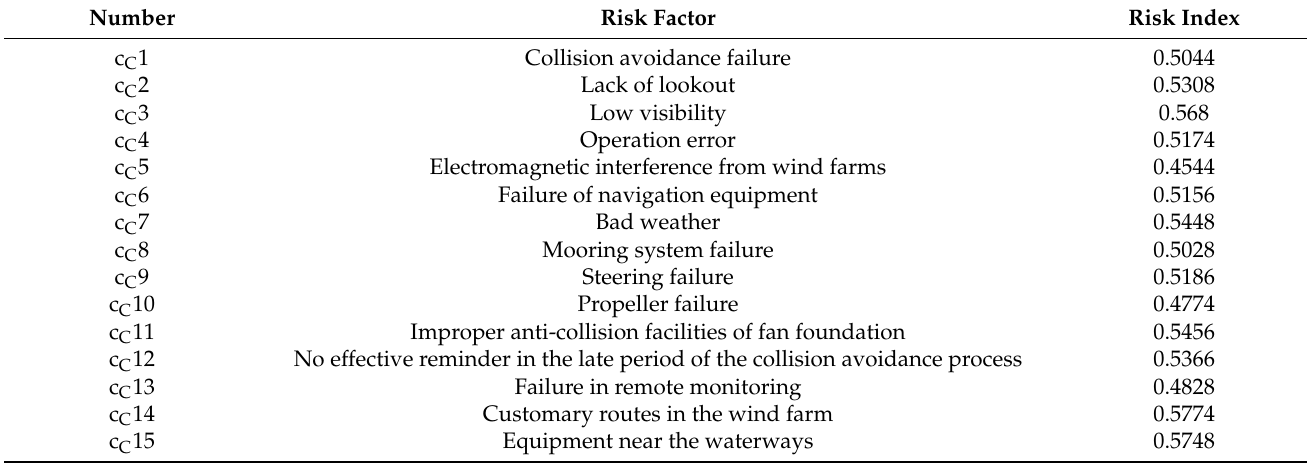
Table 7. Collision risk factors of offshore wind farms.